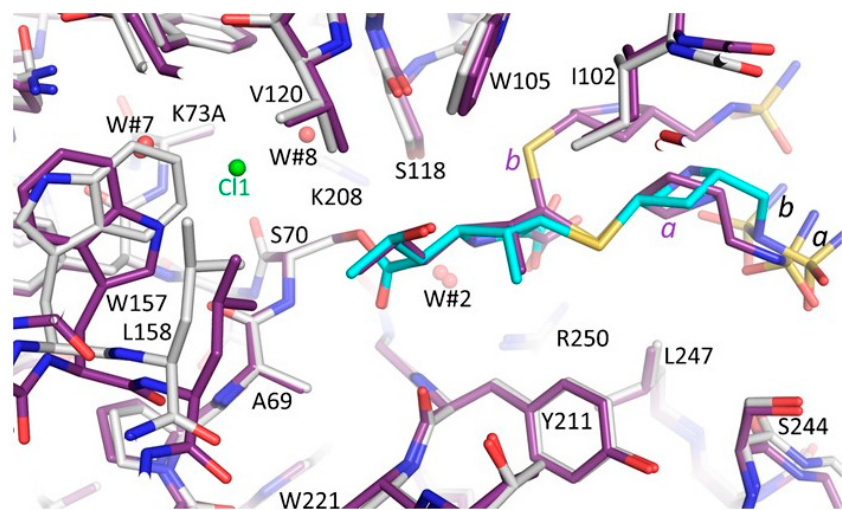
Figure 3. Stereo diagram of doripenem interactions in the active site of OXA-48 K73A molecule A. Hydrogen bonds are depicted as dashed black lines. Interacting water molecules are shown as red spheres.